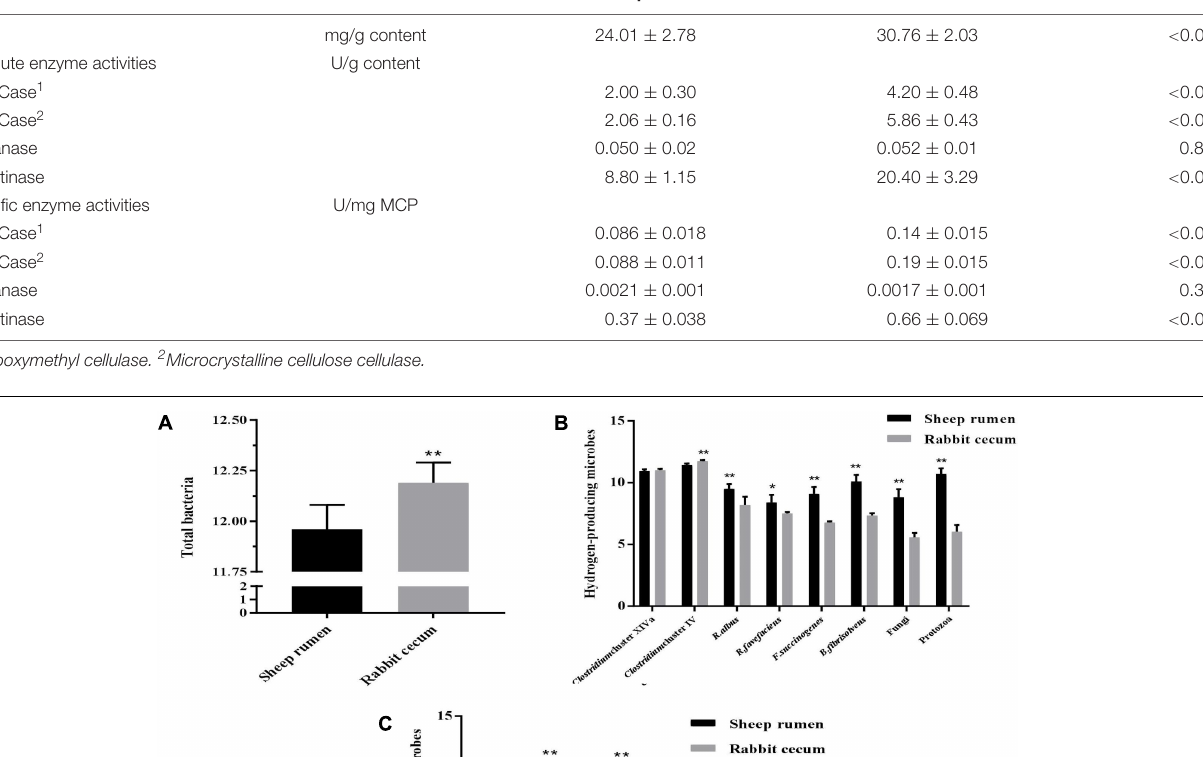
TABLE 3 | Microbial crude protein (MCP) and enzyme activities in the sheep rumen ( n = 5) and the rabbit cecum ( n = 15). Measurements